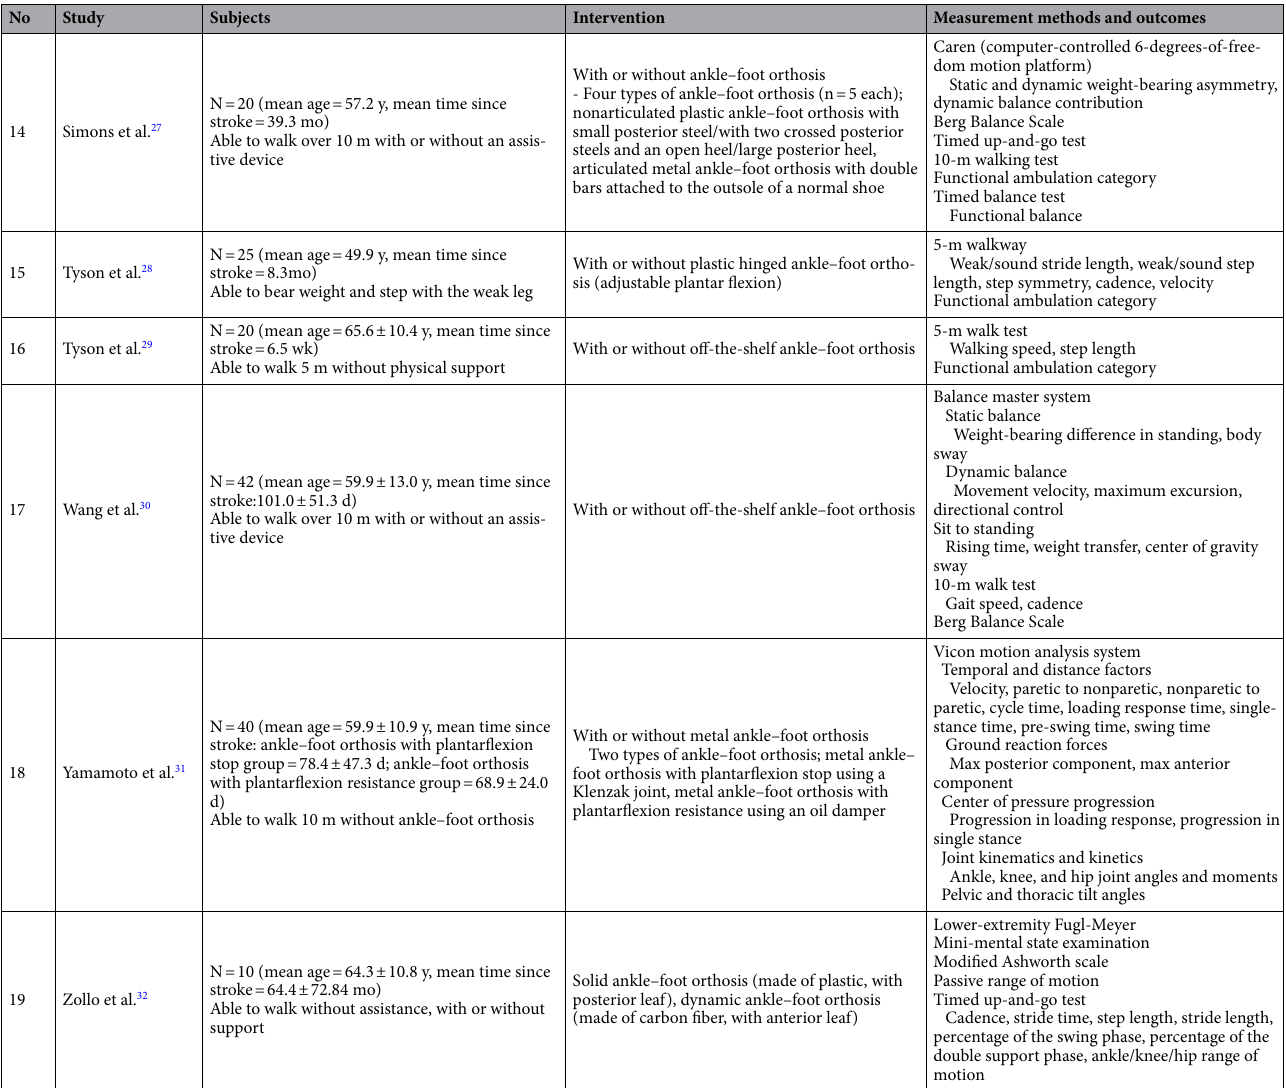
Table 1. Characteristics of the selected studies. y, years; mo, months; wk,